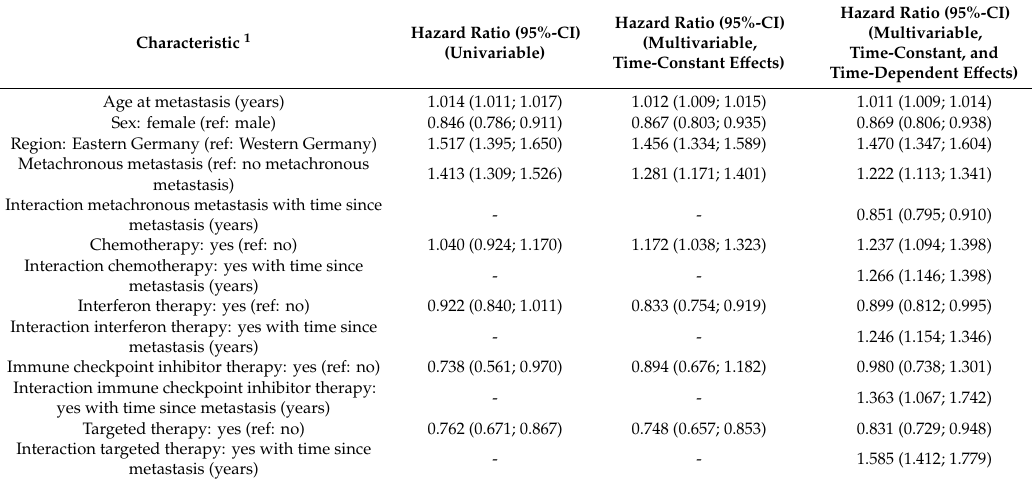
Table 2. Univariable and multivariable Cox regression results for survival since diagnosis of first metastasis, adjusted for age at metastasis, sex, region, anatomic site of the primary tumor, melanoma subtype of the primary tumor, metastasis type, and therapy ( n = 3871; events: